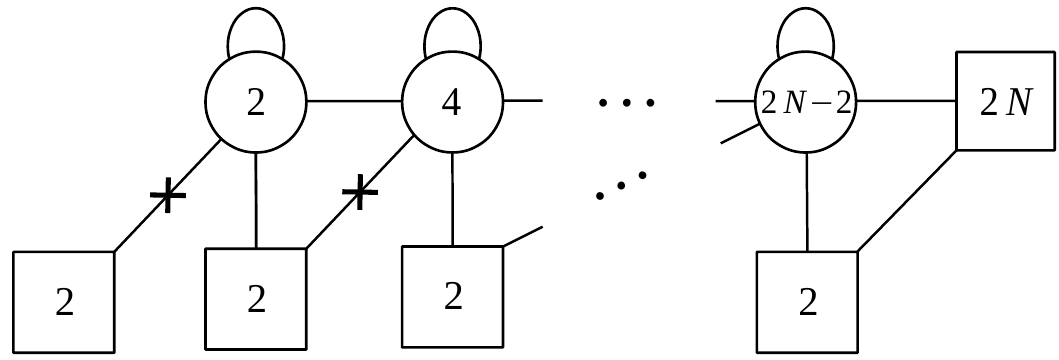
Figure 1 . Quiver diagram of the E [USp(2 N )]